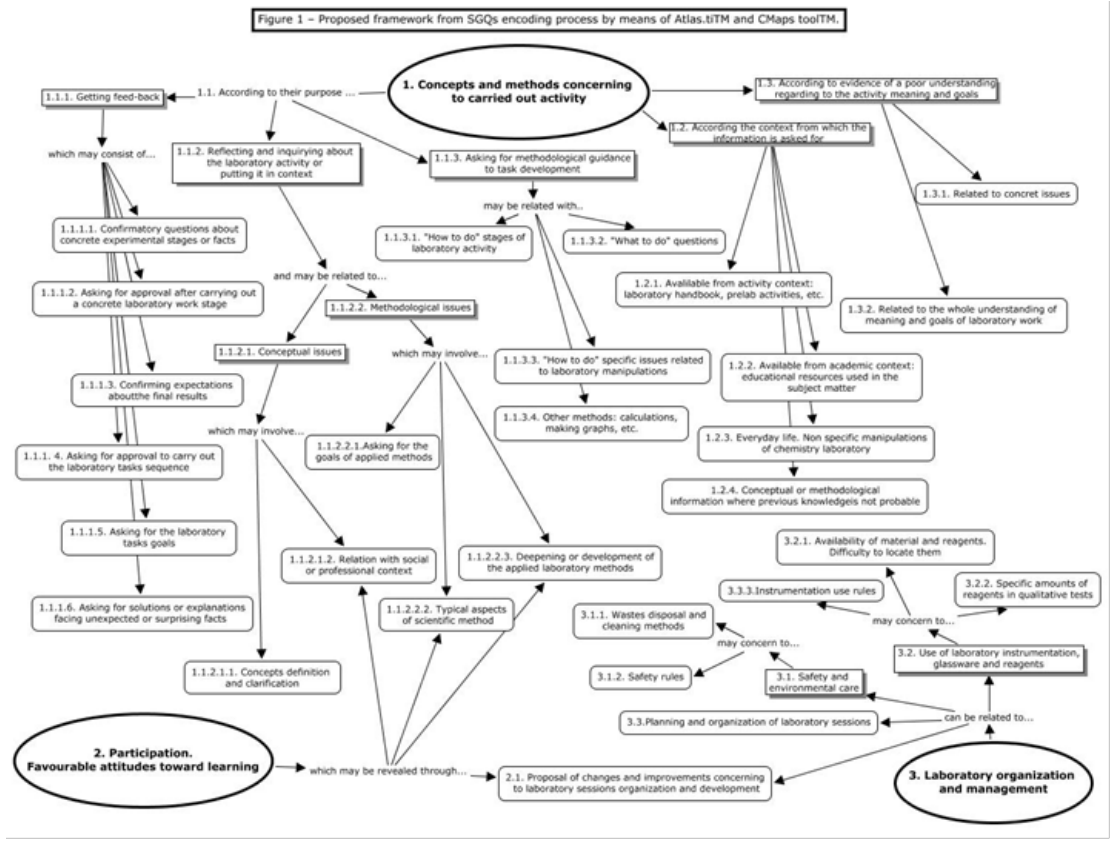
Fig. 1. Proposed encoding framework from SGQs by means of